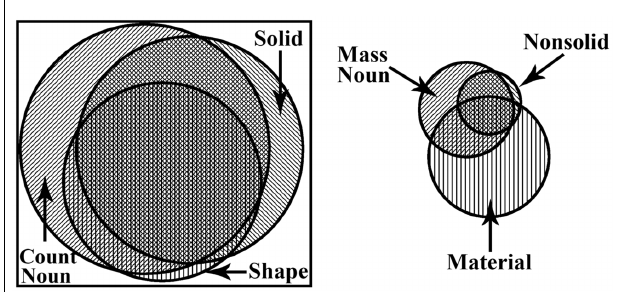
FIGURE 1 | Overlap between solidity, syntax, and category organization for the “shape side” (left) and “material side” (right) of the early noun vocabulary based on Samuelson and Smith’s (1999) analysis of adult